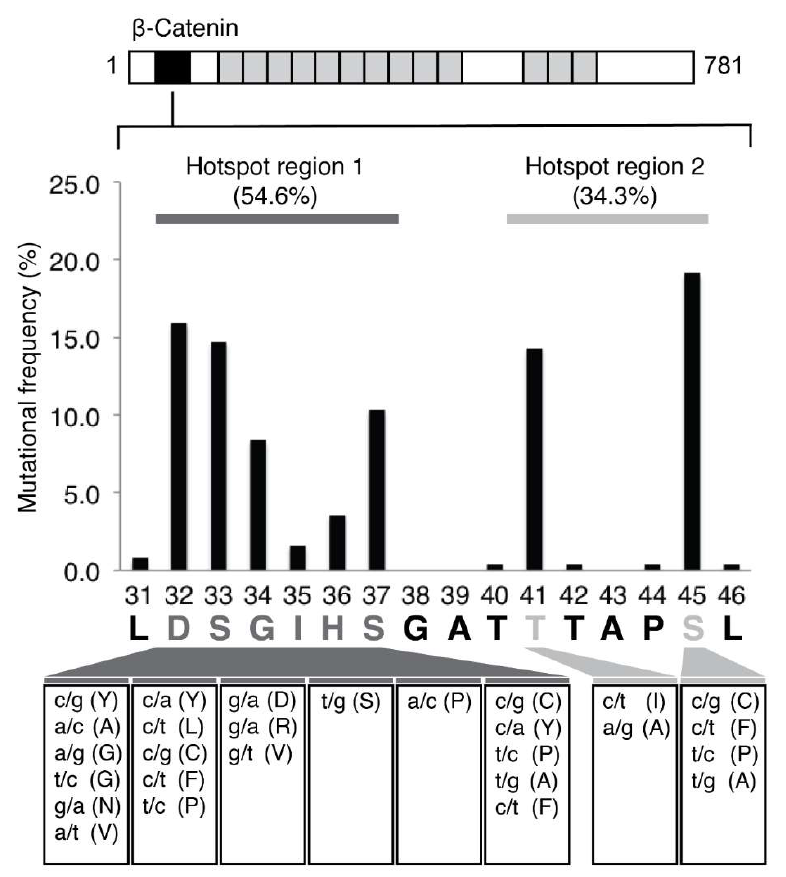
Figure 1. CTNNB1 exon 3 mutational frequency in HCC. Data from several studies that sequenced CTNNB1 exon 3 in patients with HCC were compiled (see Supplemental Table S1). In nearly 90% of all HCC tumors with a mutation in CTNNB1 , the mutation resides within one of two hotspot regions: region 1 (codons 32–37; 54.6%) and region 2 (codons 41–45; 34.3%). The X-axis denotes the codon number and amino acid encoded by it. The box linked to an amino acid lists the reported missense mutations within the codon and the corresponding amino acid changes.